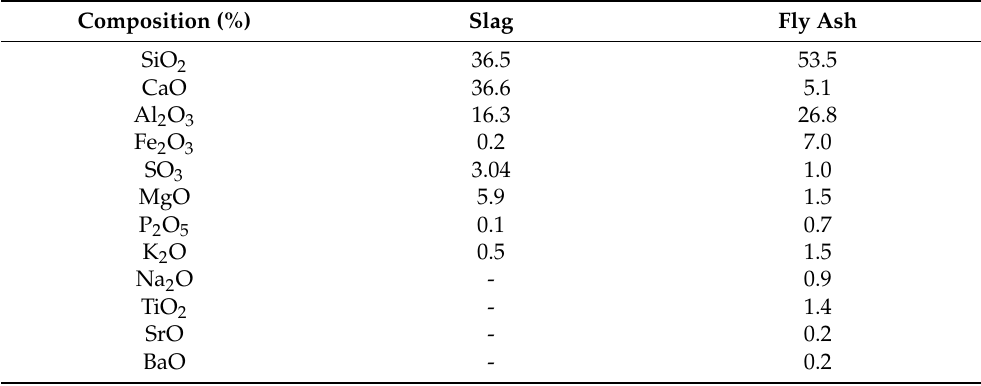
Table 1. Chemical composition of slag and fly